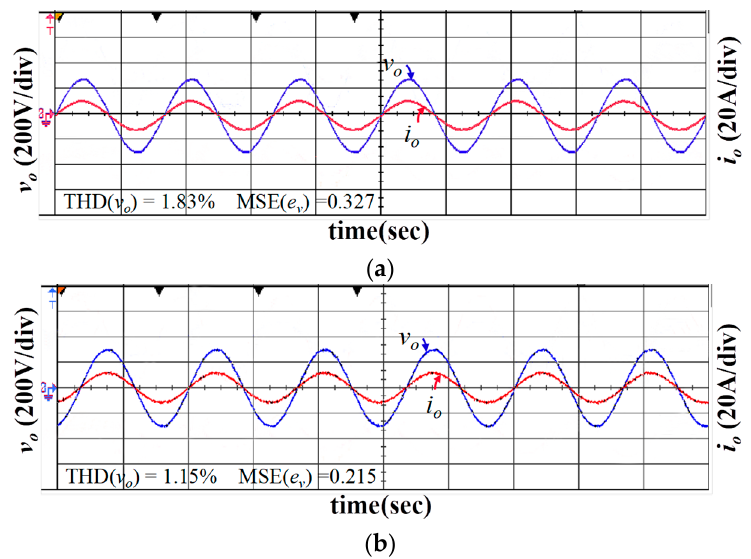
Figure 10. Experimental results under resistive load: ( a ) SMC; ( b ) the proposed AFSMC.